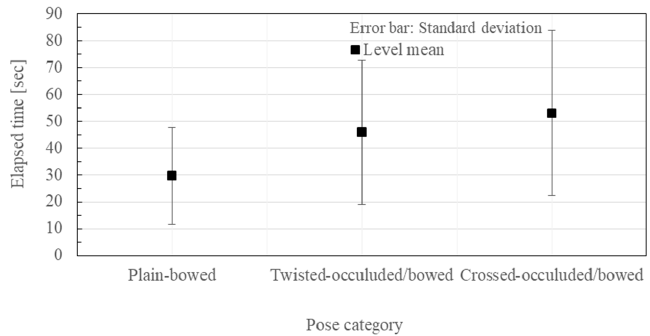
Figure 9. Experimental results of the pose-reproduction. The pose category factor effect.